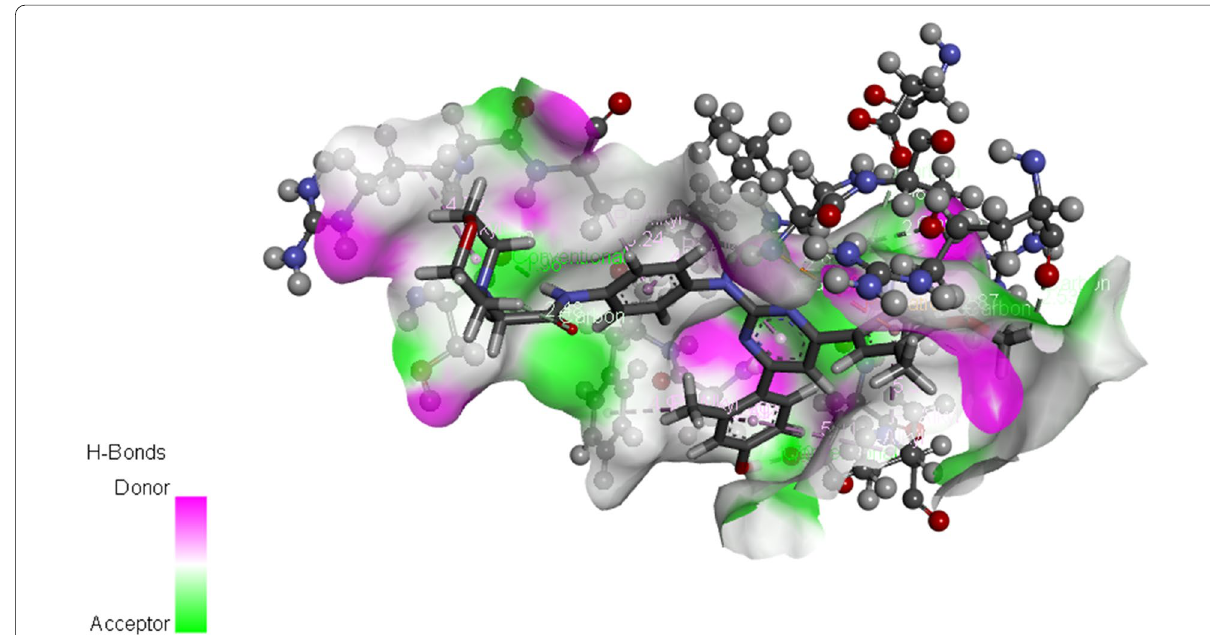
Fig. 9 3D structure of the designed compound 2 interactions with VEGFR-2 receptor